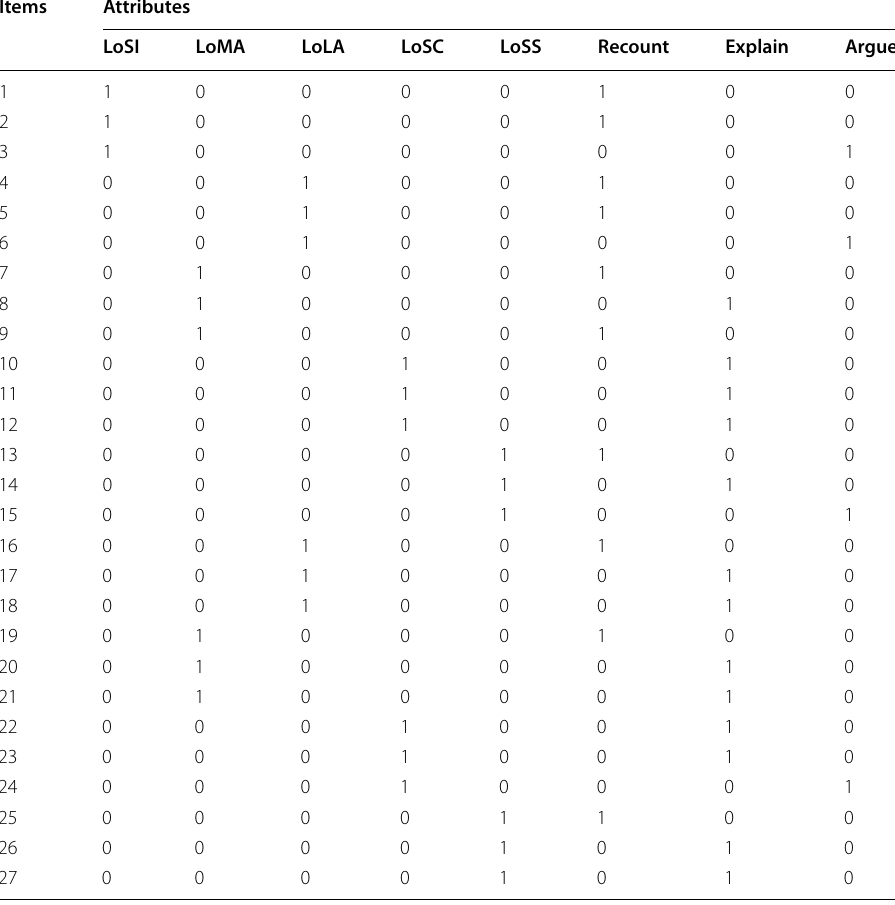
LoSI social instructional language, LoMA language related to math, LoLA language related to language arts, LoSC language related to science, LoSS language related to social studies